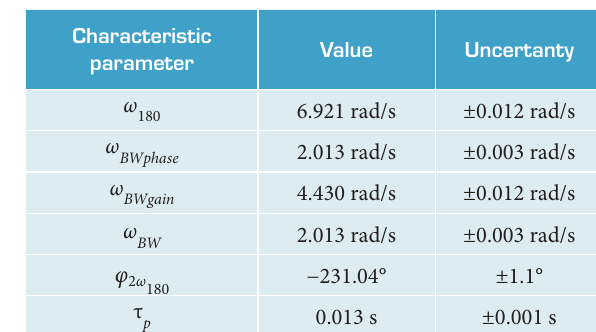
Table 2. AS355-F2 level flight (80 KIAS) lateral flying qualities ADS